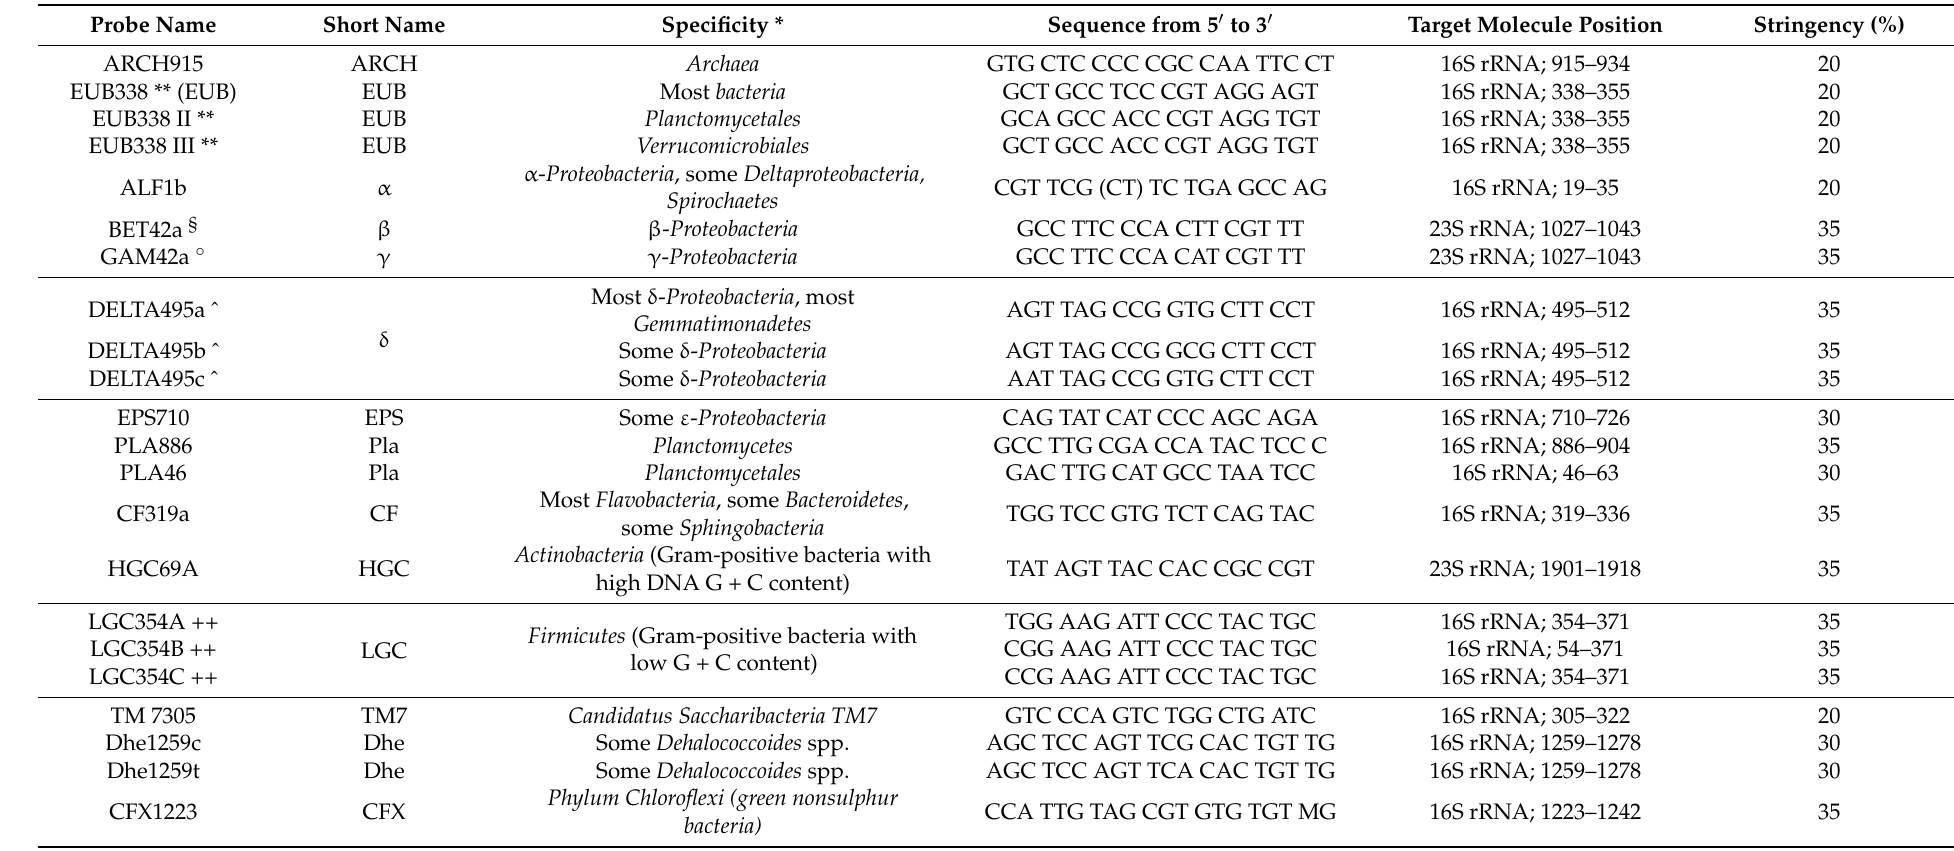
Table 1. List of the oligonucleotide probes used: specificity, sequences, target sites, and % formamide used in the FISH hybridization buffer